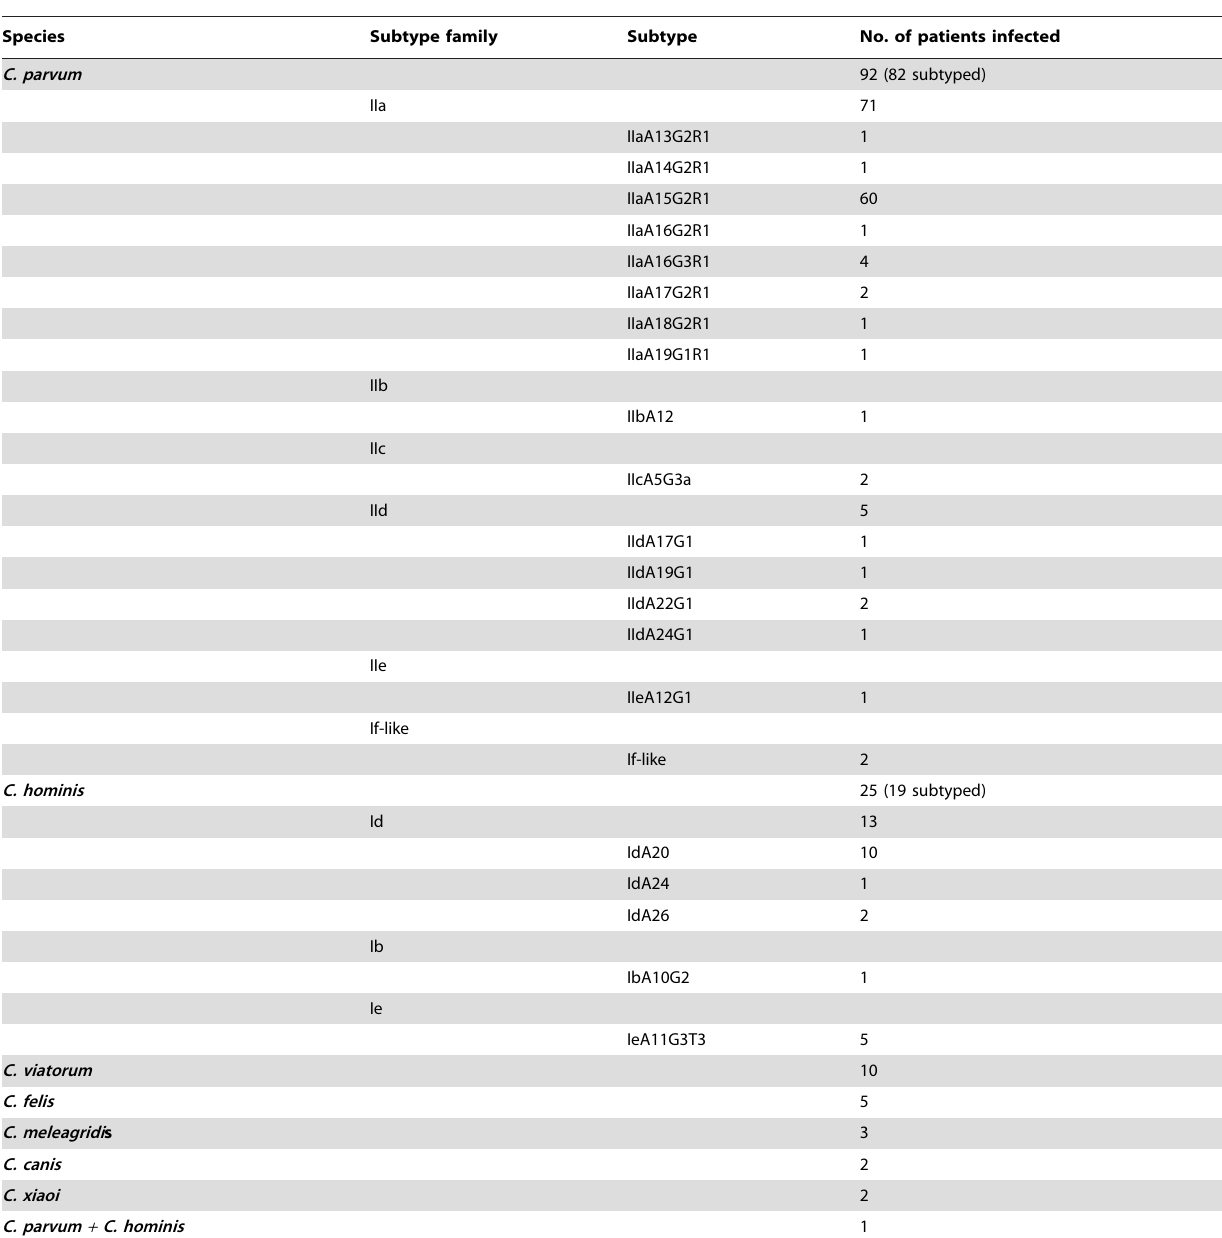
Table 2. Distribution of Cryptosporidium species and C. parvum and C. hominis subtypes in HIV/AIDS patients in Ethiopia